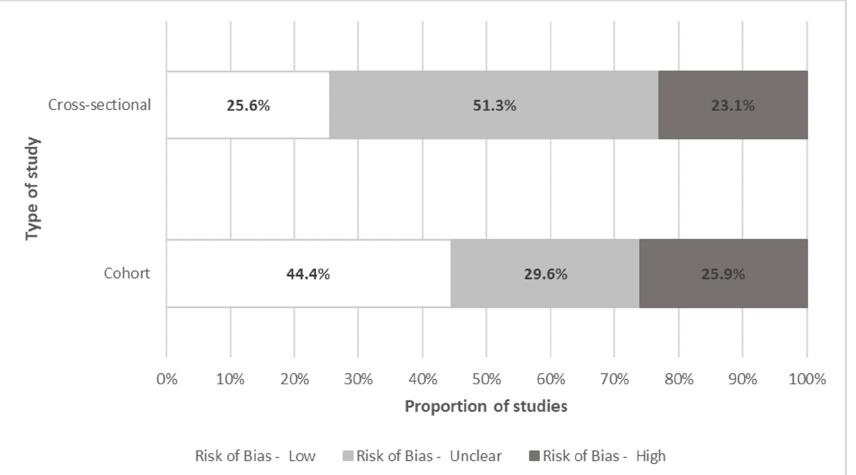
Figure 7. Quality assessment of individual studies. Note: This figure shows the proportion of studies with low, unclear or high risk of bias, as per the Ottawa-Newcastle Assessment Tool for cohort and cross-sectional studies. The dimensions evaluated for risk of bias were patient selection, comparability, and outcome assessment.